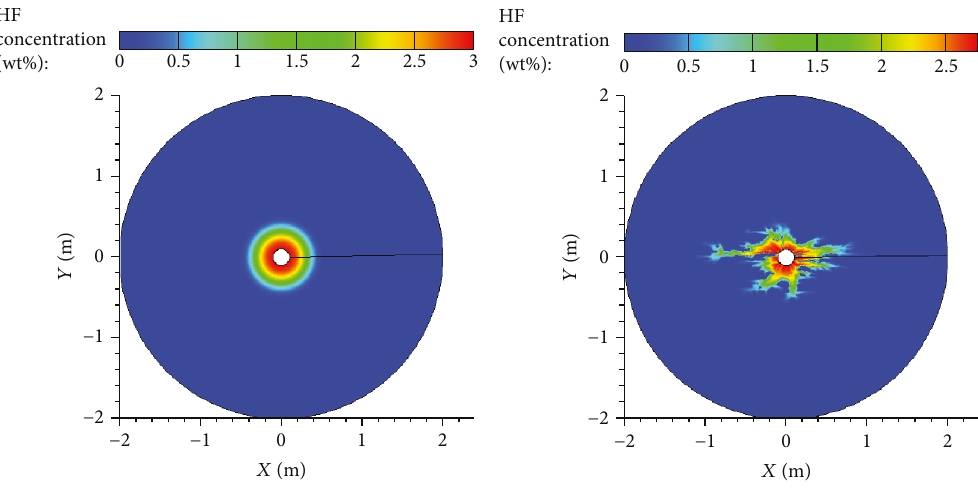
Figure 7: HF distribution after acidizing for homogeneous and heterogeneous initial